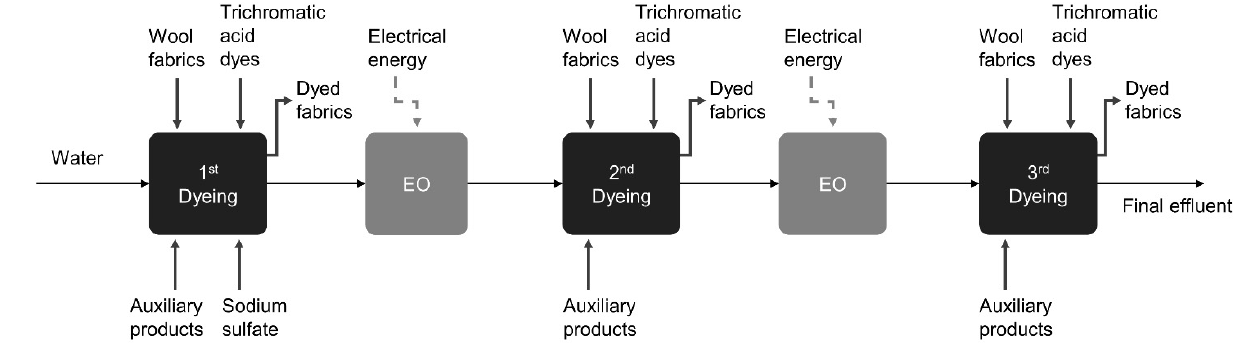
Figure 2. A schematic diagram of the processes.